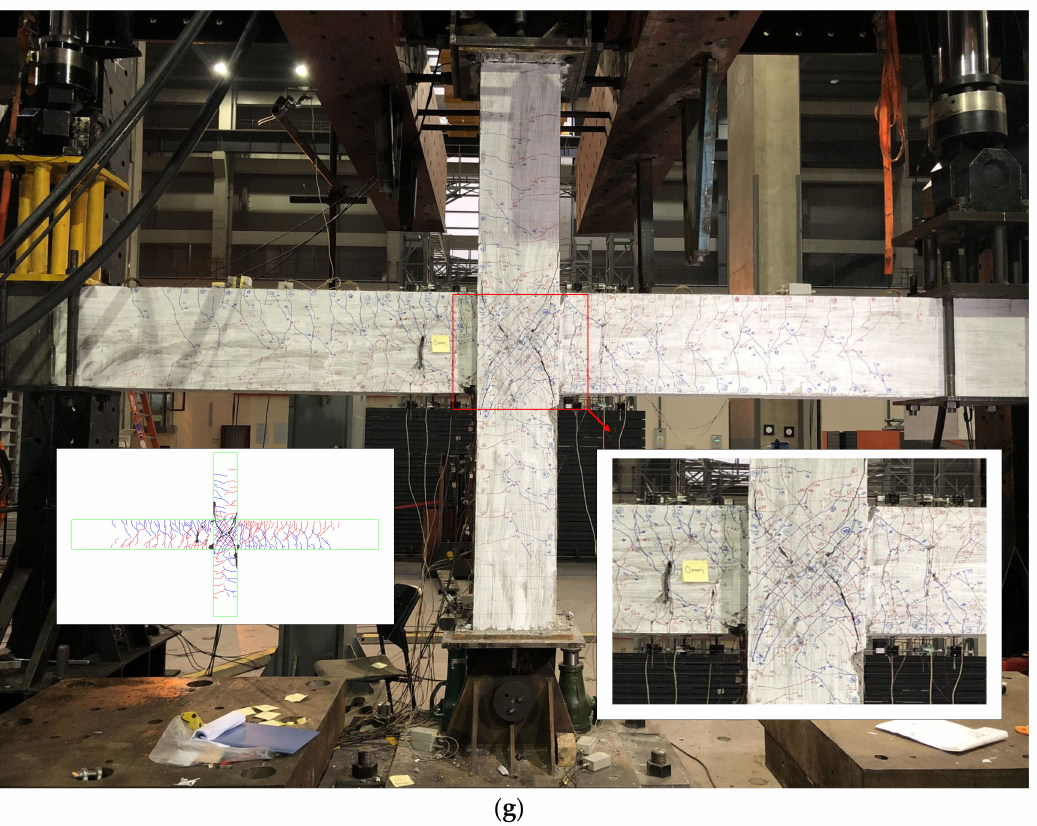
Figure 5. Failure modes. ( a ) Specimen PI1, ( b ) Specimen PI2, ( c ) Specimen PI3, ( d ) Specimen PI4, ( e ) Specimen PI5, ( f ) Specimen PI6, ( g ) Specimen